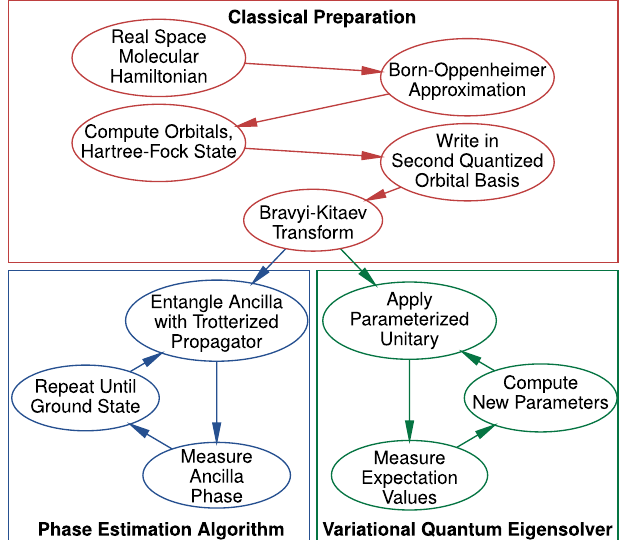
FIG. 5. A flow chart describing steps required to quantum compute molecular energies using both PEA and